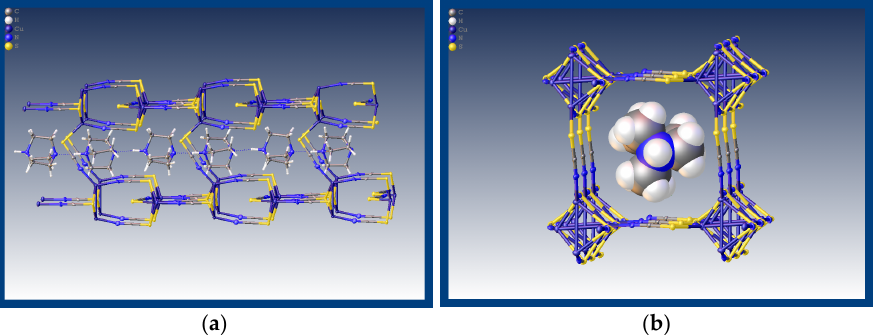
Figure 2. Infinite anionic 3D {[Cu 2 (SCN) 3 ] − } n network in structure 1 : view along 100 ( a ) and 001 ( b ) directions.